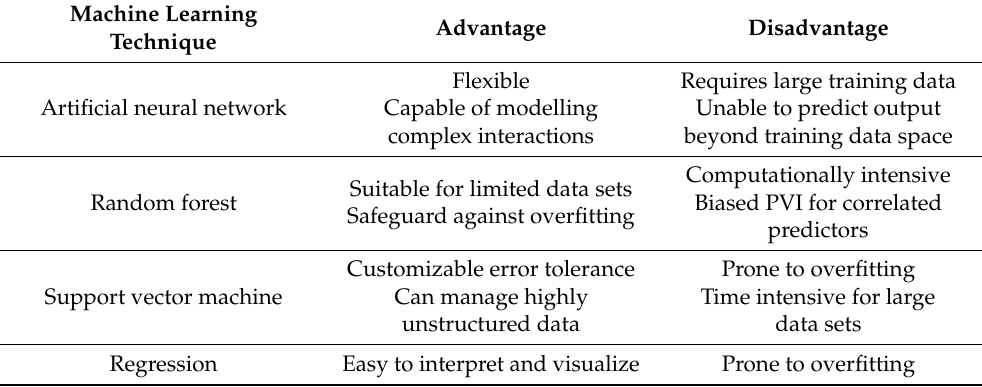
Table 3. Advantages and disadvantages of the different machine learning